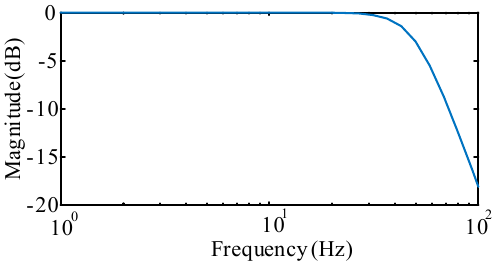
Figure 5. Attenuation characteristics of the third-order FRF.